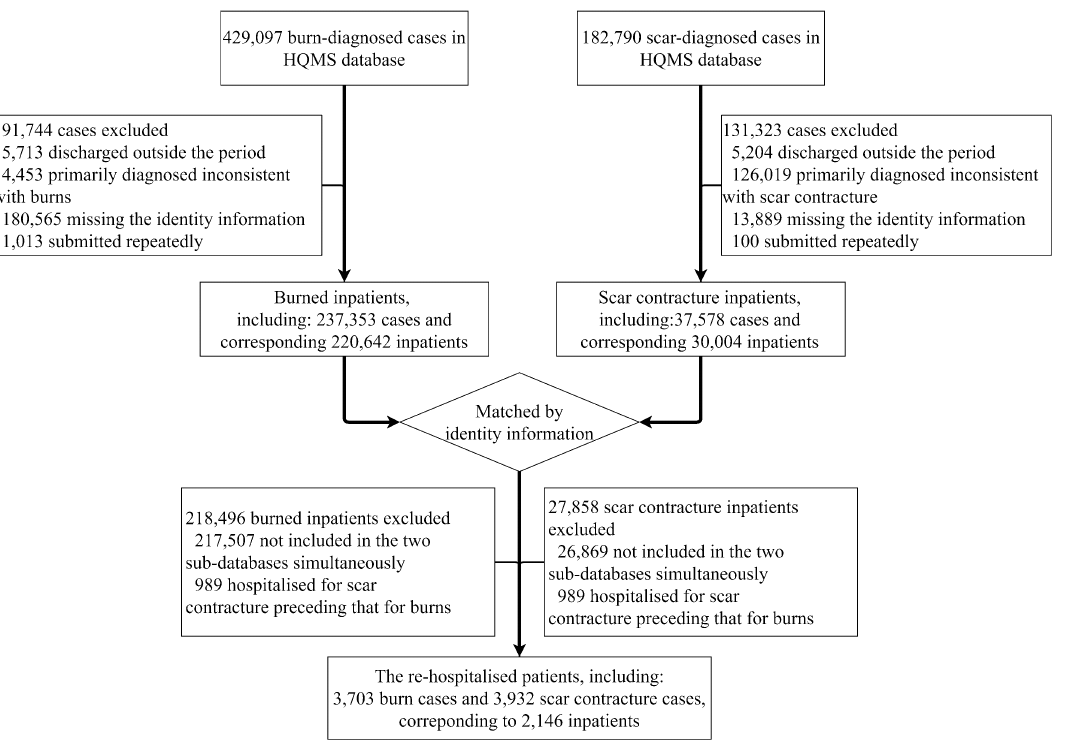
Figure 1. Flow chart for identifying burn inpatients and scar contracture-associated re-hospitalised inpatients. Abbreviation: HQMS Hospital Quality Monitoring